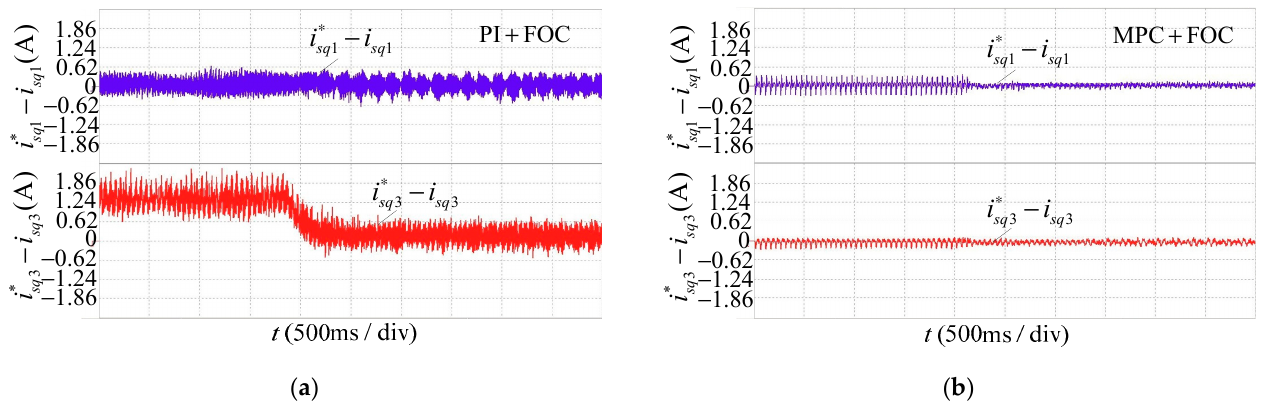
i and i under PI+FOC; and ( b ) track- 1 sq 3 sq